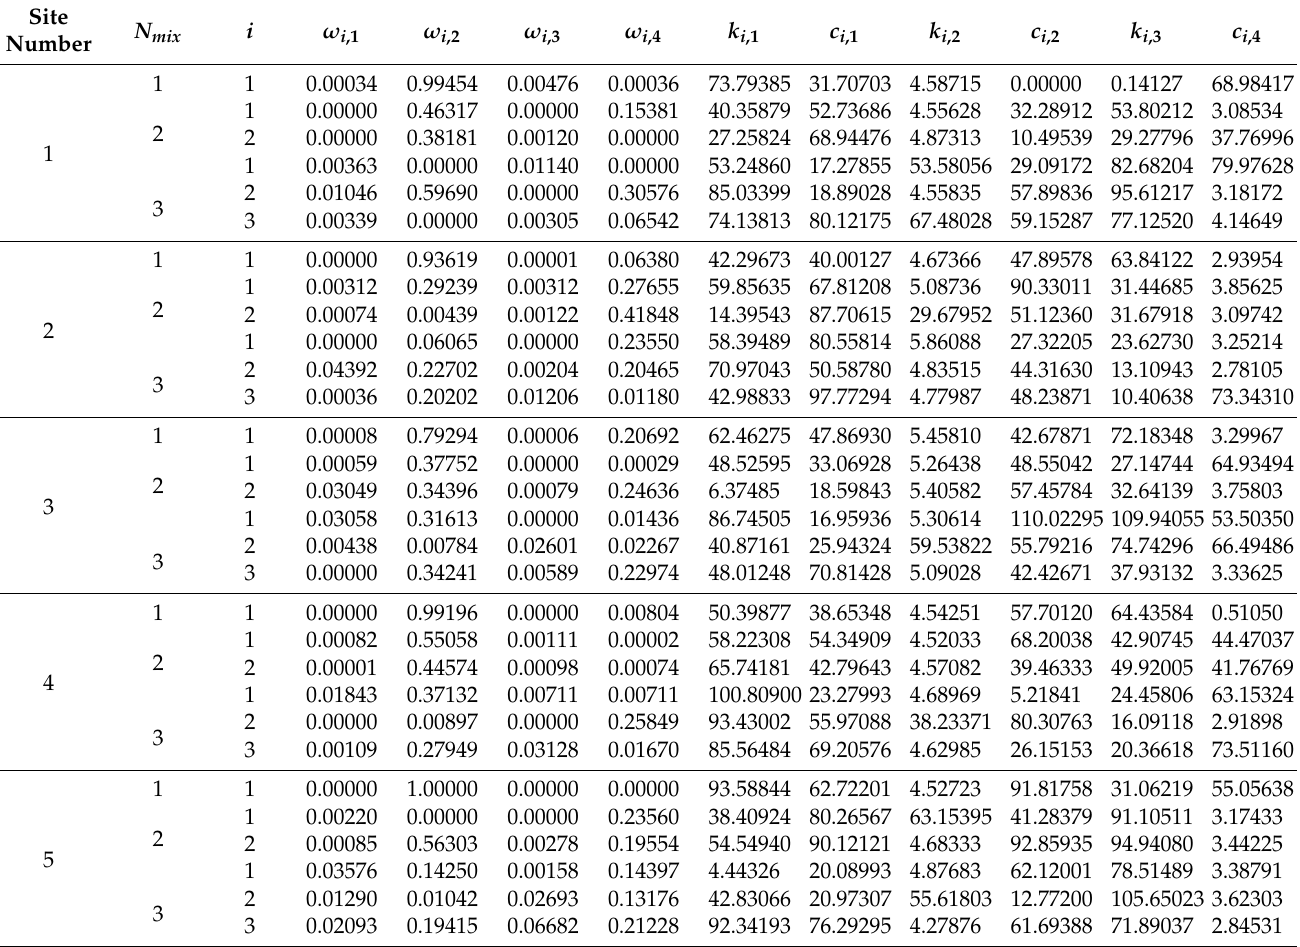
Table 5. Weights and PDFs parameters of f mix for 30 equal wind speed spacings using the NSGA- II